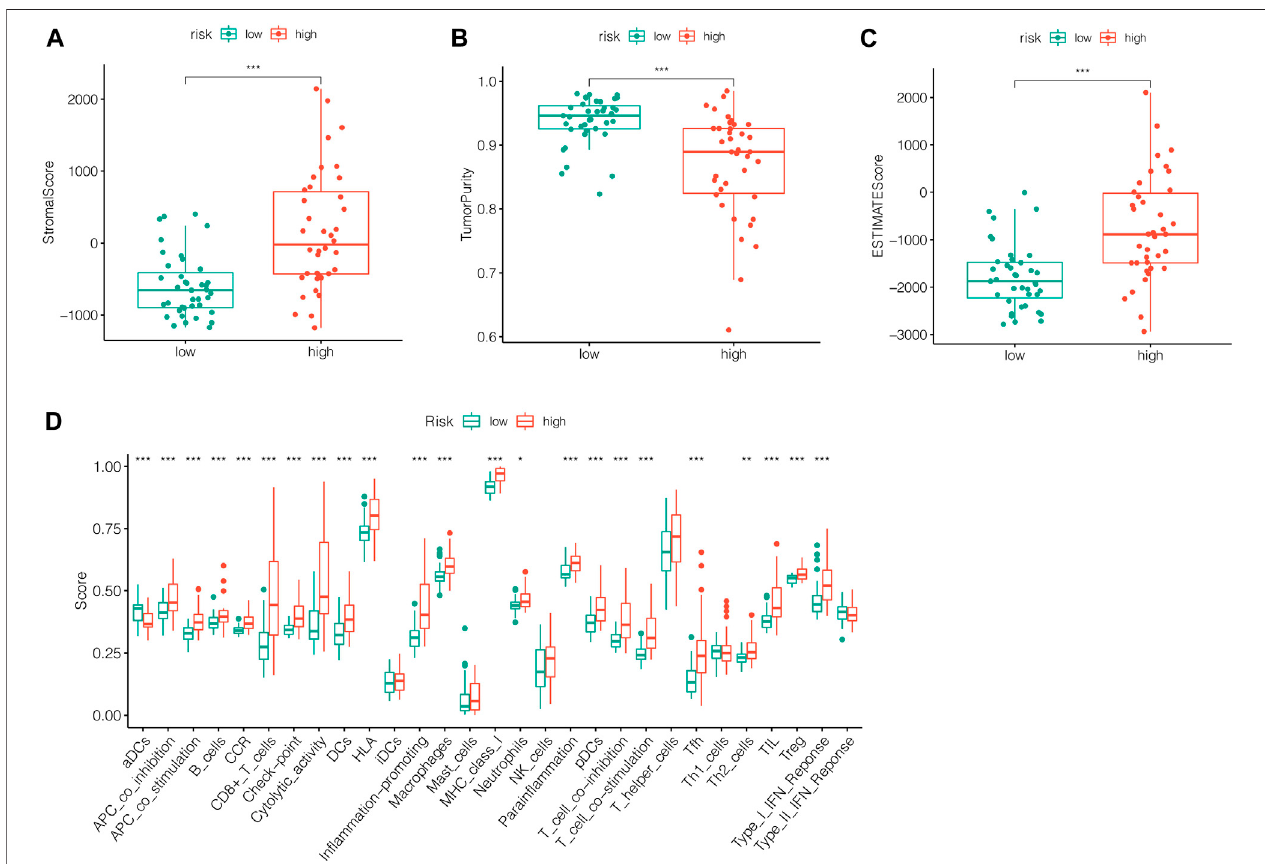
FIGURE 8 | Analysis of immune score between two groups. (A) The stromal score was higher in the high-risk group than in the low-risk group ( p < 0.001). (B) Patientsinthehigh-riskgrouphadlowertumorpurityscoresthanthoseinthelow-riskgroup( p < 0.001). (C) TheESTIMATEscorewashigherinthehigh-riskgroupthan in the low-risk group ( p < 0.001). (D) The total immune score of patients in the high-risk group showed a higher trend.